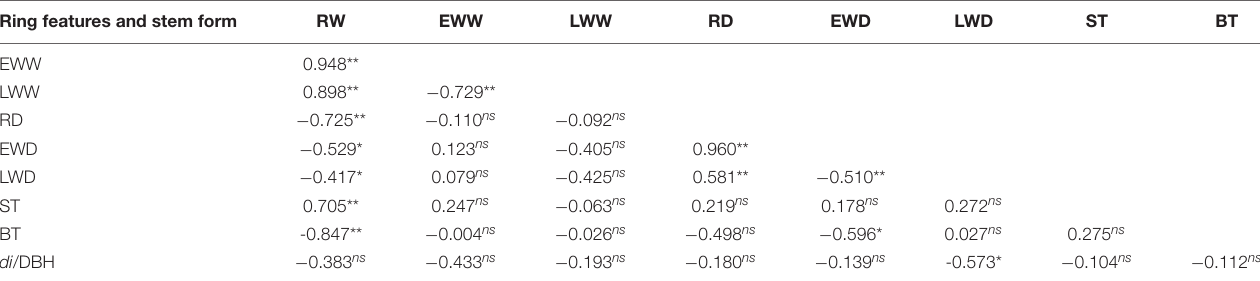
FIGURE 6 | Variation of ST (A) , BT (B) , and d i /DBH (C) during self-thinning S. tzumu stands. TABLE 4 | Pearson’s correlation coefficients (and significances at the 5% level) between RW, WD, and ST during self-thinning S. tzumu